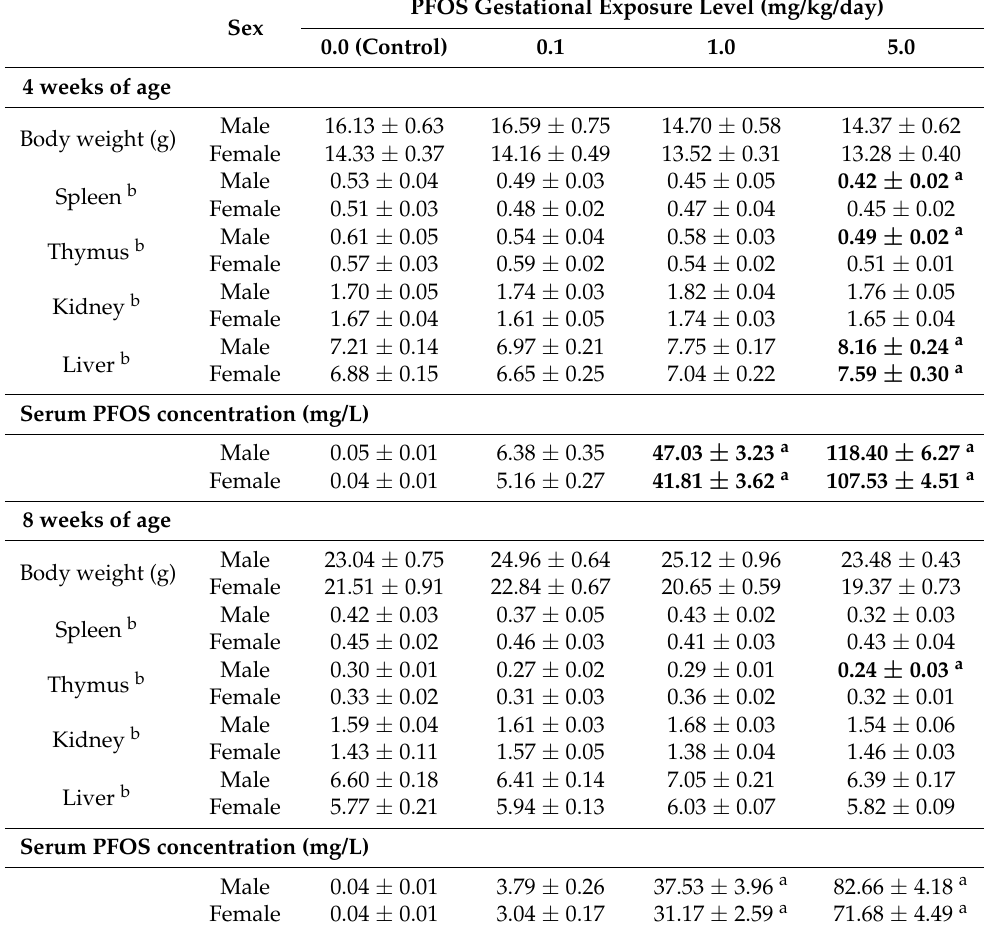
Table 1. Body weight, organ parameters and serum PFOS concentrations in C57BL/6 mice exposed in utero to PFOS during Gestation Days (GD)